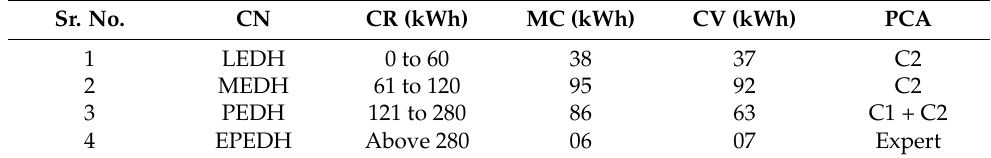
Table 12. Consumer classification and its validation using the SOM with KM indirect clustering method. Sr.